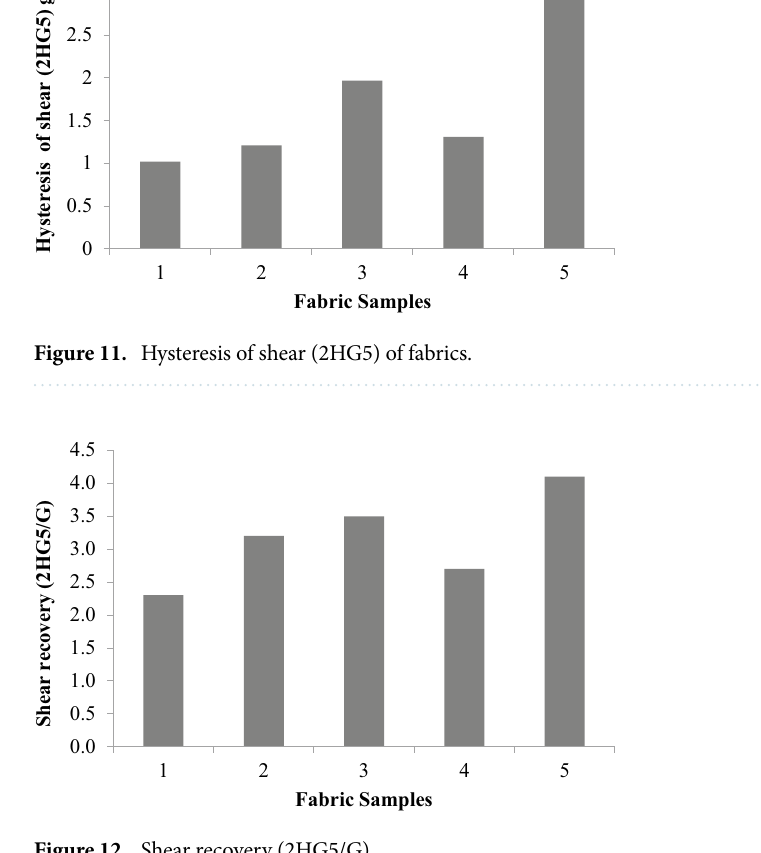
Figure 12. Shear recovery (2HG5/G).